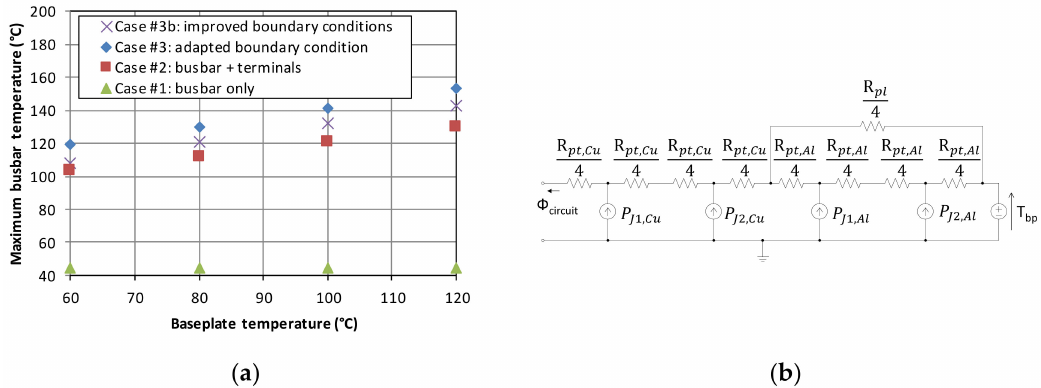
Figure 12. Comparison of different calculation methods to estimate the maximum busbar temperature (Module M): ( a ) Effect of the baseplate temperature— I eff = 150 A; ( b ) More representative thermal circuit of module M power